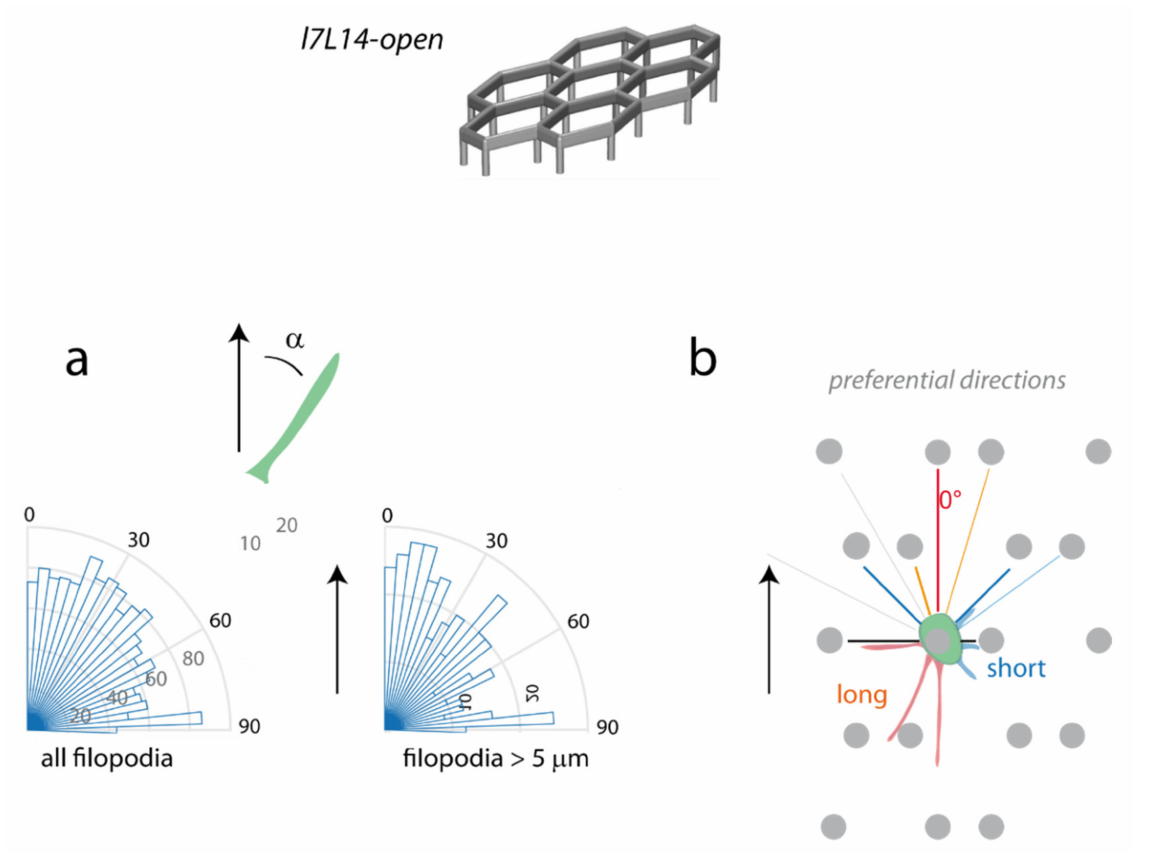
Figure A4. Histograms of filopodia orientations in elongated structures. ( a ) The angle with the reference axis of elongated structures was computed (top). Bottom, left: all filopodia, right: filopodia with lengths > 5 µ m. ( b ) Remarkable angles in elongated microstructures (grey circles: pillars). Preferential orientations of short ( ≤ 5 µ m, blue) and long (>5 µ m, red)